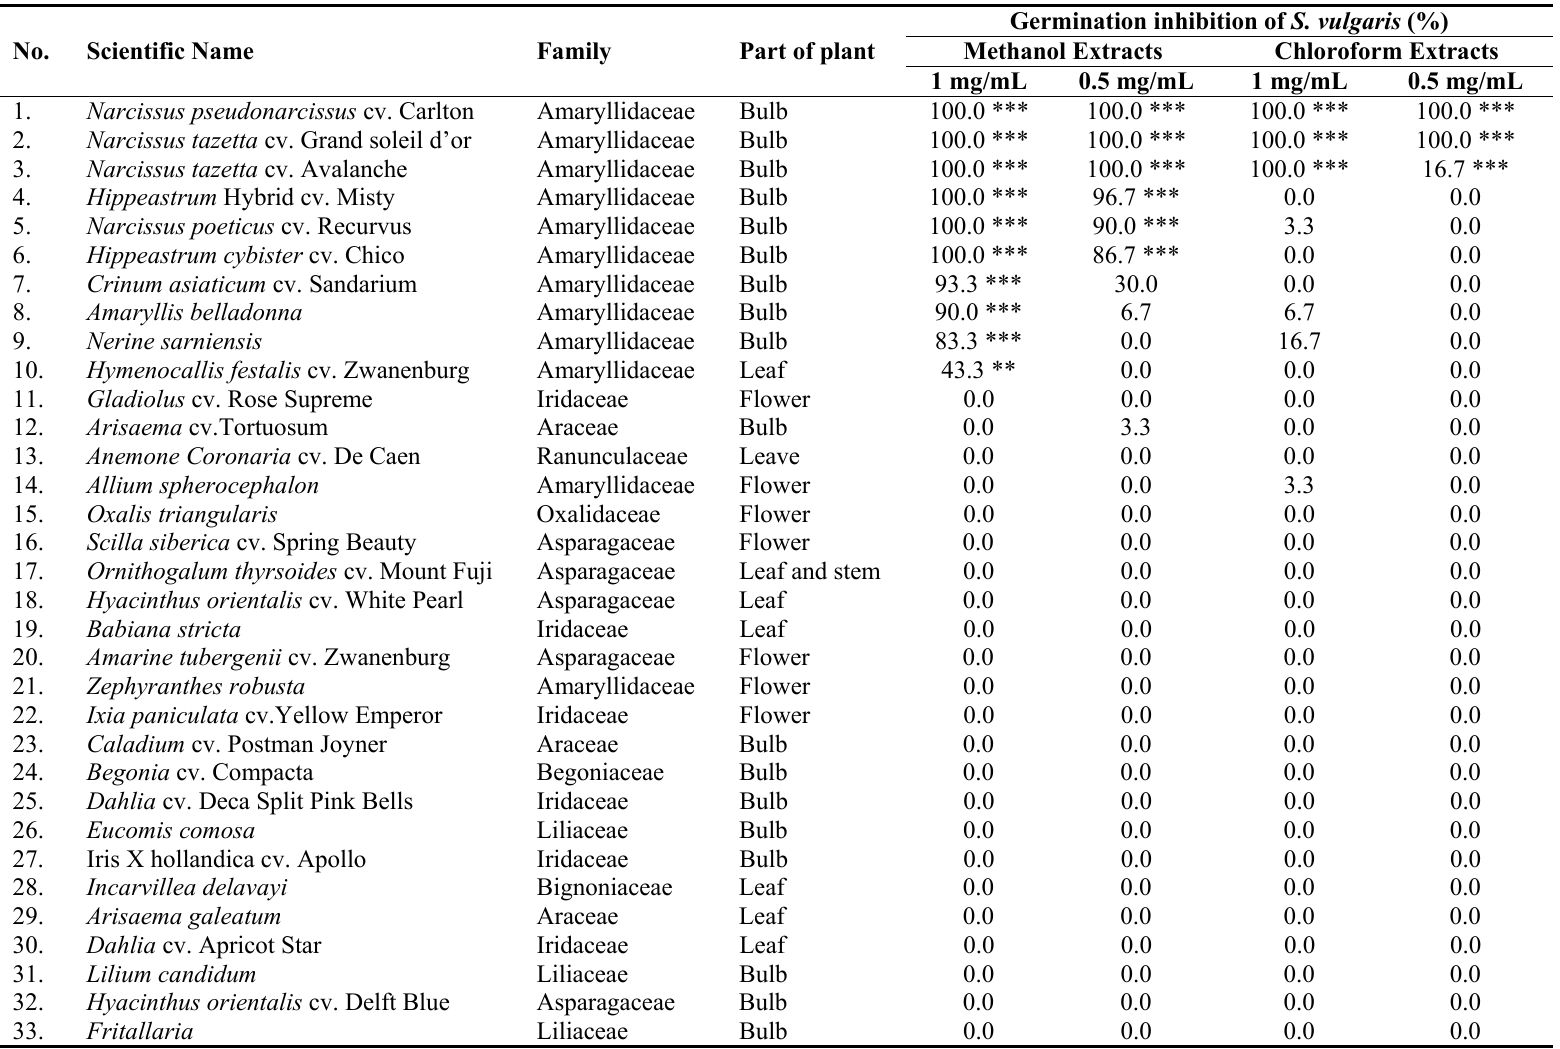
Table 2. The effect of methanol and chloroform extracts, derived from 33 flower bulb species, on Senecio vulgaris seed germination at concentrations of 0.5 and 1.0 mg/mL. Data present the mean of three replicates. Significant inhibition is indicated as: *** p ≤ 0.001 and ** p ≤ 0.01.